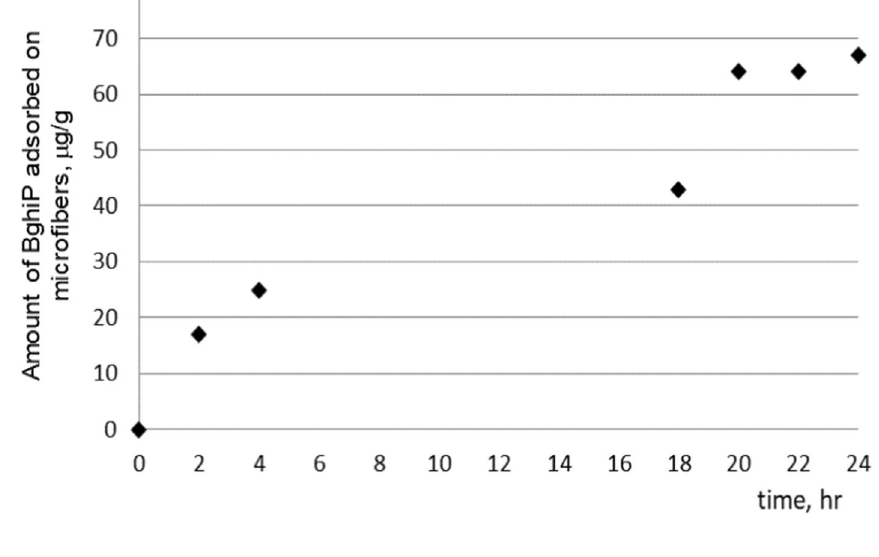
Fig. 7 Indeno(1,2,3,c,d)pyrene (μg/g) adsorbed on microfibers as a function of time